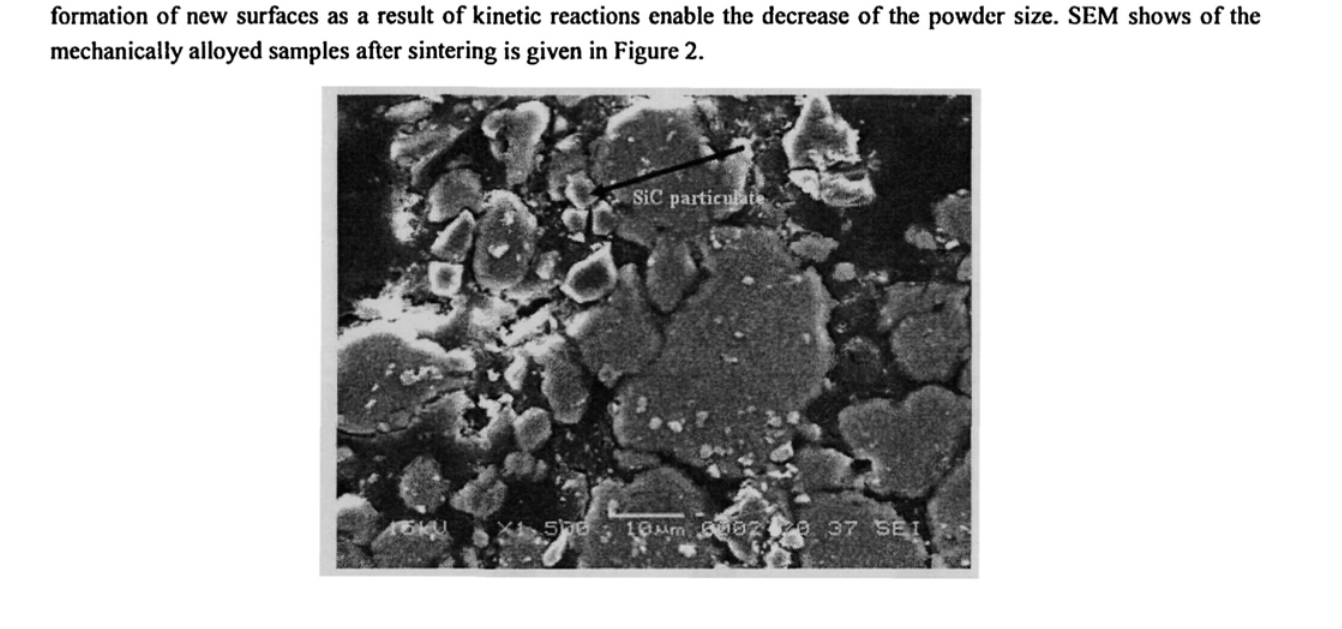
reinforced (a), 10% SiC p